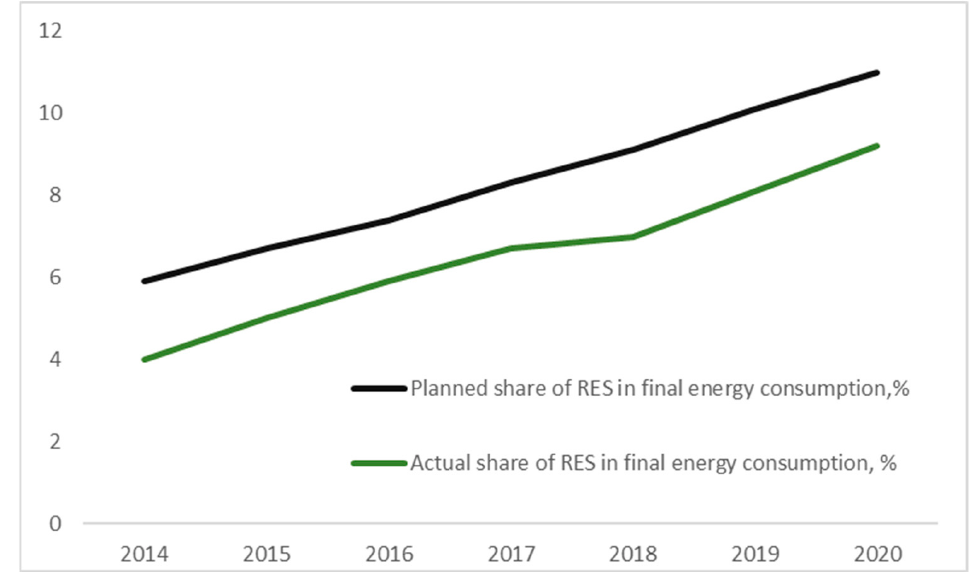
Figure 3. The share of energy from renewables in final energy consumption, % [14].